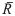
The Callitris ring-width chronology from the Pilbara region in northwest Australia.(a) Ring-width indices, (b) measures of signal strength, the R- (RBAR) and the expressed population signal (EPS), and (c) sample depth. The black dashed line indicates the accepted level of confidence of the EPS (0.85). The shaded area indicates the point (1802) when the EPS drops below 0.85 and therefore when the chronology is considered to be less reliable.